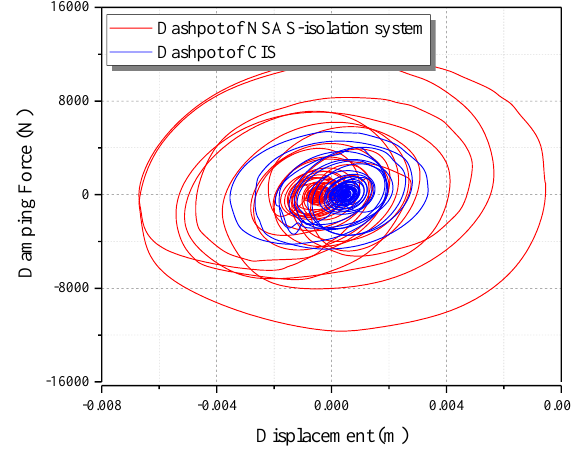
isolation system. isolation system. Appl. Sci. 2020 , 10 , x FOR PEER REVIEW